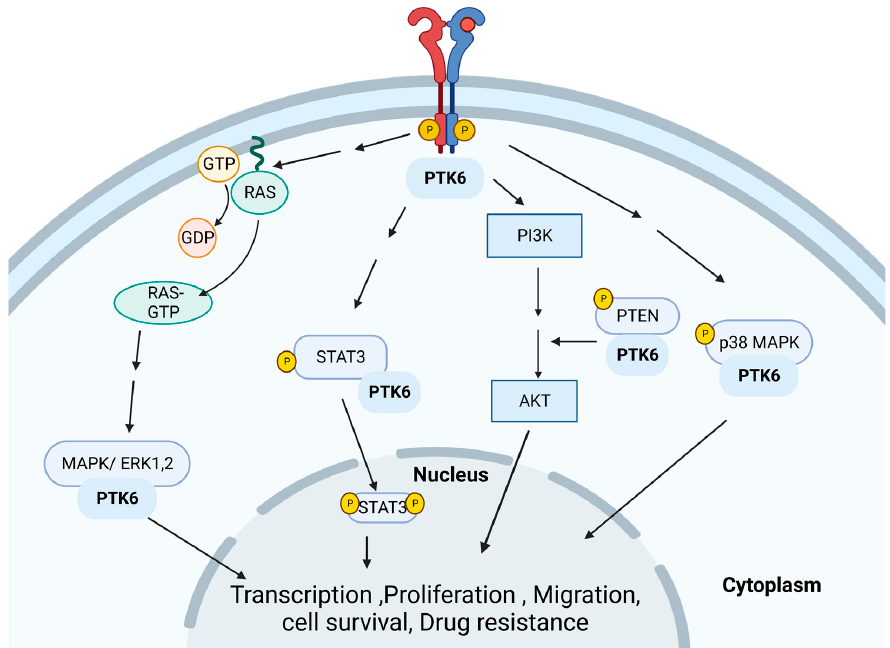
Figure 6. A diagram of PTK6 signaling. PTK6 activates several signaling pathways, such as JAK/STAT, PI3K, and MAPK, which enhance cell proliferation, invasion/migration, and resistance. Created with BioRender.com.